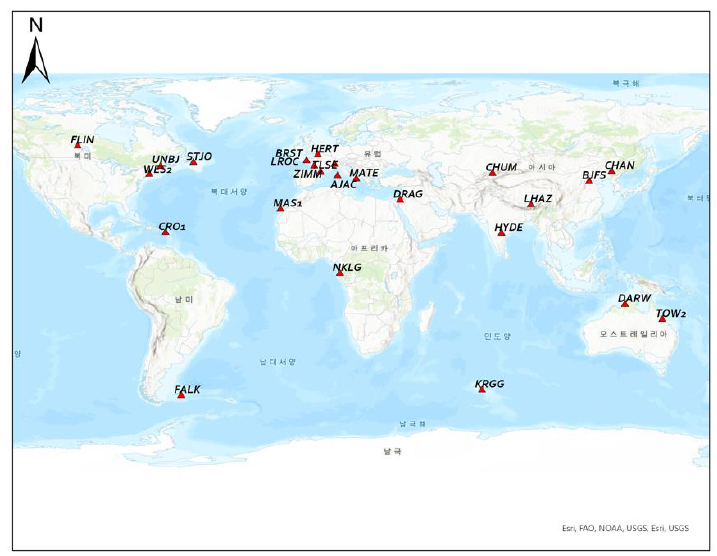
Figure 3. The 25 geometrically distributed IGS stations used in the paper. Table 2. The list of IGS stations.